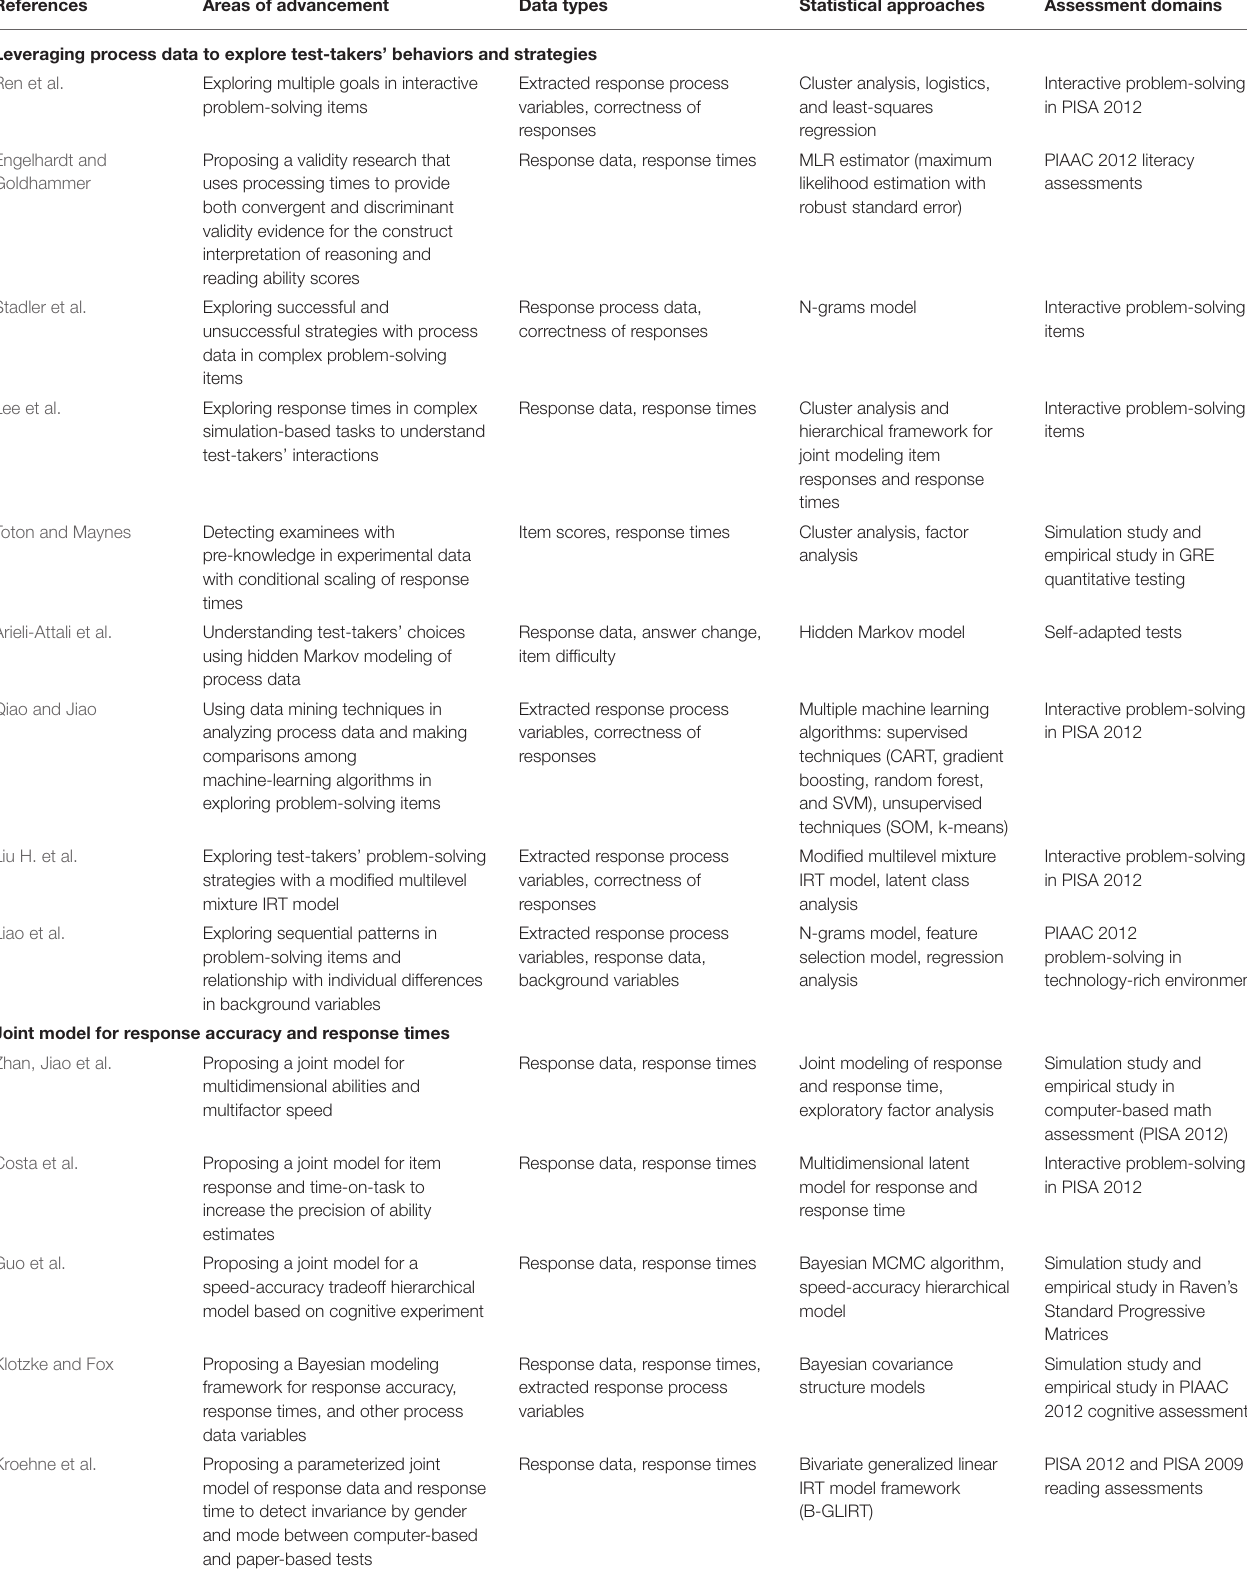
TABLE 1 | An overview of papers collected in this Research